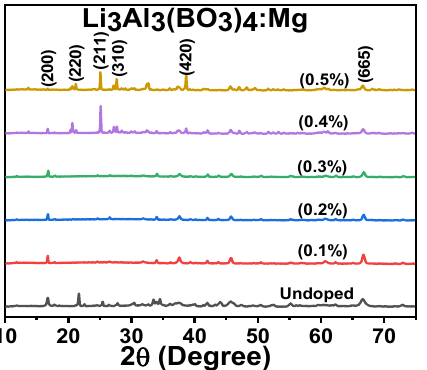
Figure 1. The XRD outline for the Mg-doped and undoped lithium aluminium borate.